Question: Summarize what this figure shows in one sentence.
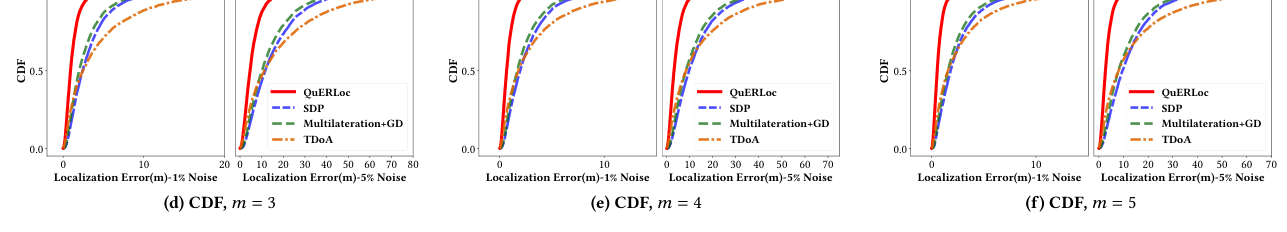
Answer: Performance of QuERLoc and baselines with same anchor utilization. QuERLoc and all baseline methods conduct distance ranging with the same set of anchors.